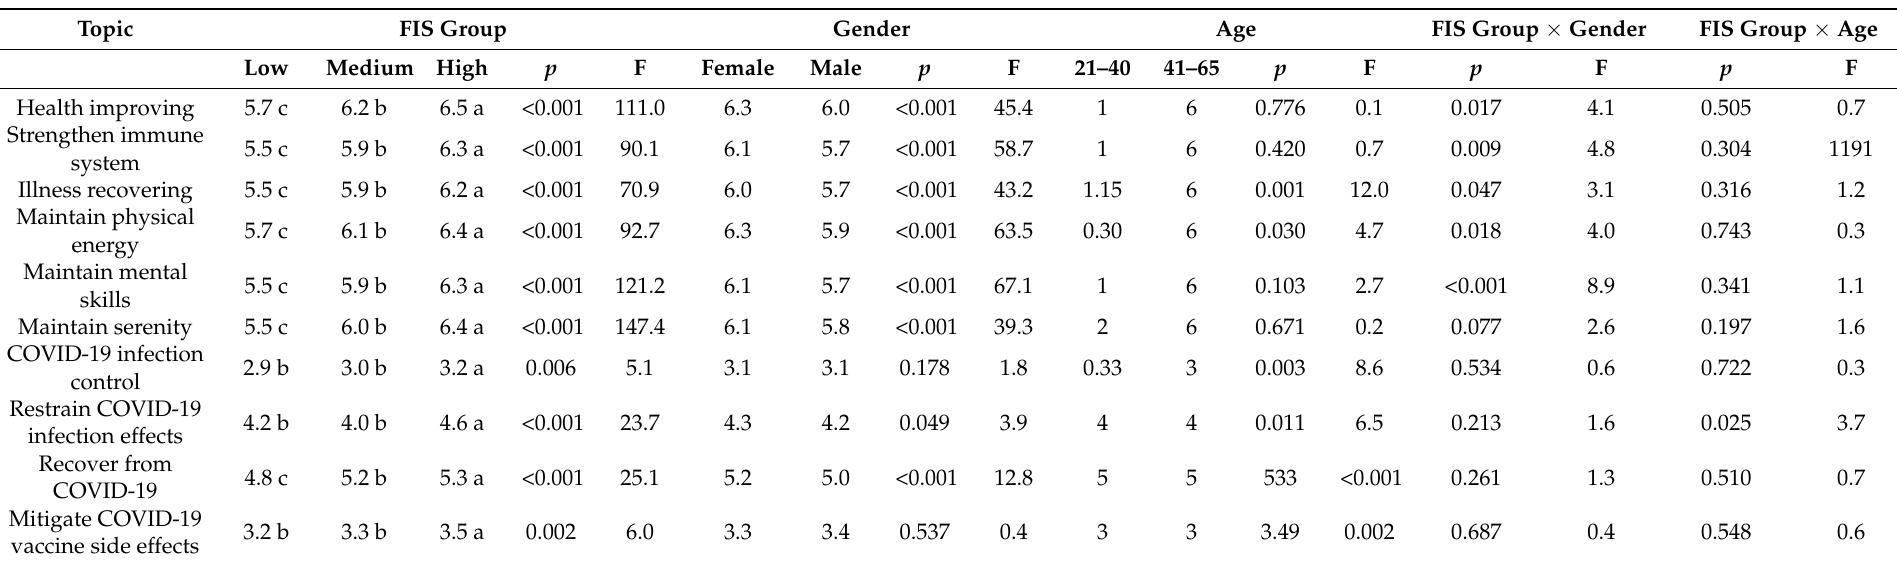
Table 5. Three-way ANOVA model on food consumption frequency in the pre-COVID period. FIS group, gender, and age were used as fixed factors with